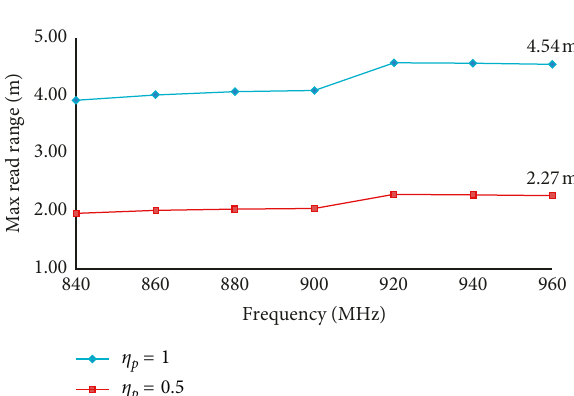
Figure 17: Simulated read range of the epidermal RFID double- loop tag with meandered lines in two directions for readers with circular (red line) and linear (blue line) polarizations. Figure 18: Simulated S 11 (a) and antenna input impedance (b) of the second tag placed on layered elliptical and planar